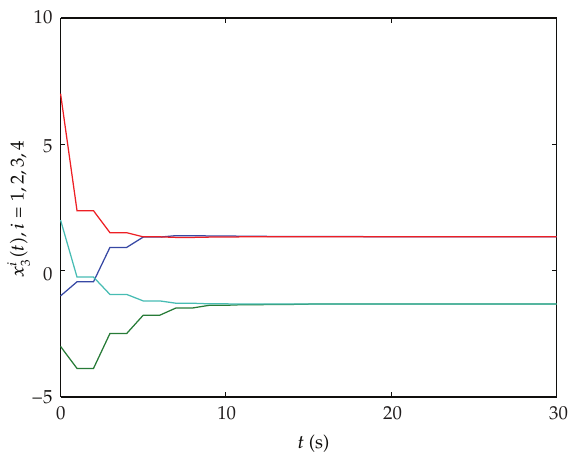
(cid:6) t (cid:7) , i (cid:9) 1 , 2 , 3 , 4 for G 3